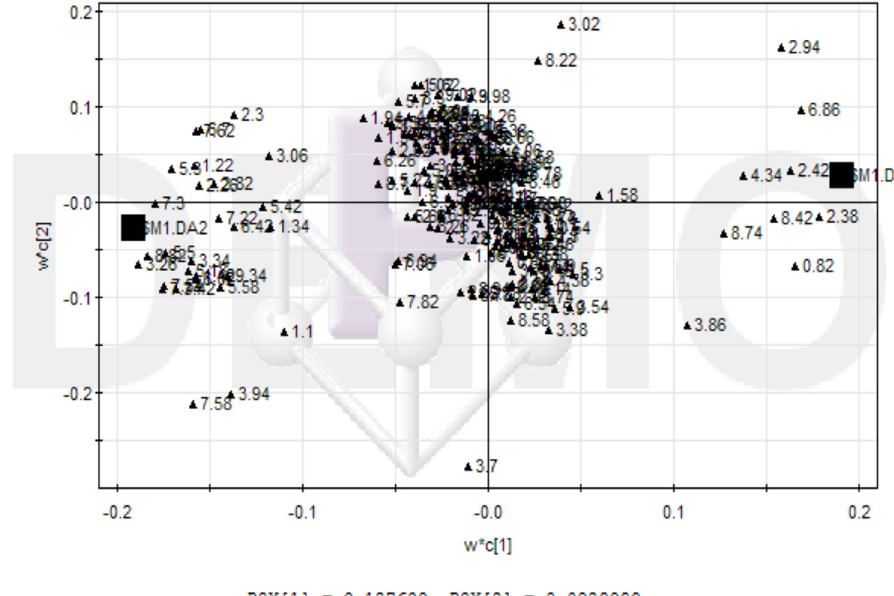
FIGURE 7 - Loading plot of the proton nuclear magnetic resonance ( 1 H NMR) spectra of serum samples from the control and acute pancreatitis (AP) groups (6-h, 12-h, and 24-h).